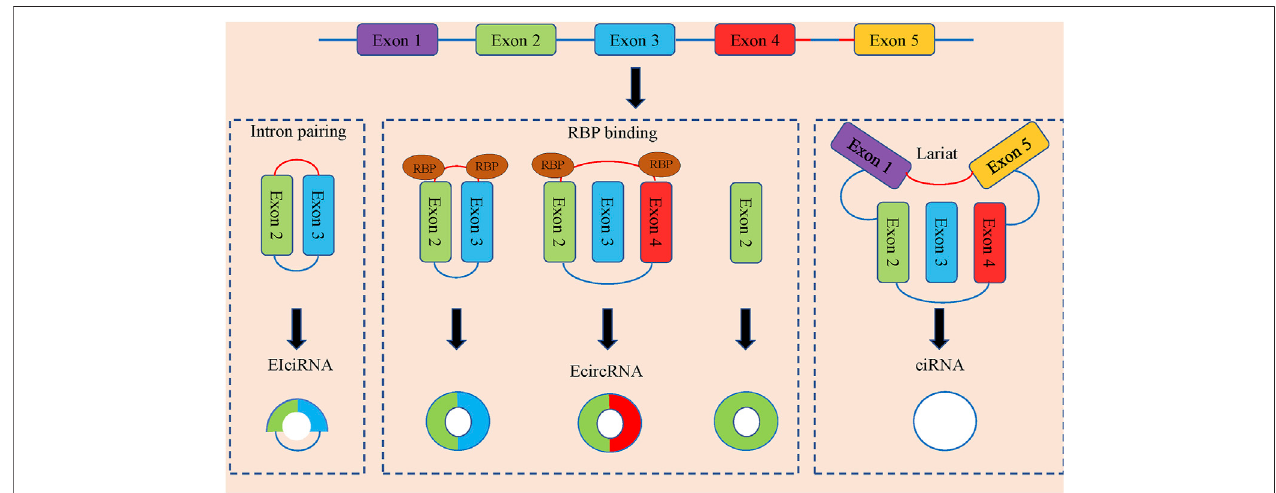
FIGURE 1 | The formation and classi fi cation of circRNAs. CircRNAs are commonly divided into EIciRNAs, EcircRNAs and ciRNAs in accordance with their components, which were derived from exons and introns, and both of them in pre-mRNAs, respectively. Latant ecircRNAs can be generated from one pre-mRNA via alternative splicing. The red segment and blue segment between Exon 4 and Exon 5 represented a 7-nt GU-rich motifnear the 5 ′ splice site and an 11-nt C-rich motifat the branchpoint site, respectively, which promoted the generation of ciRNAs.